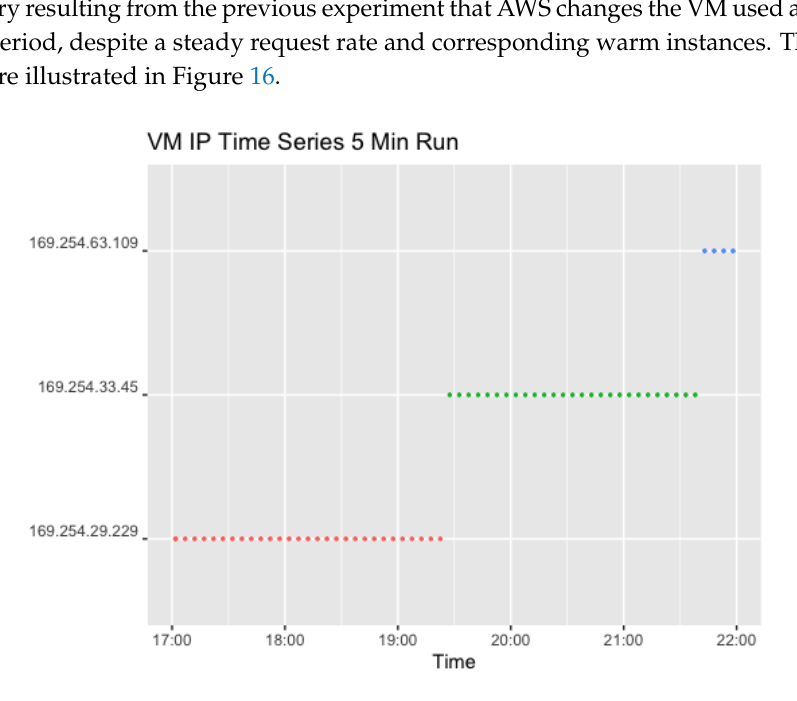
Figure 16. IP changes of a 5 min request rate